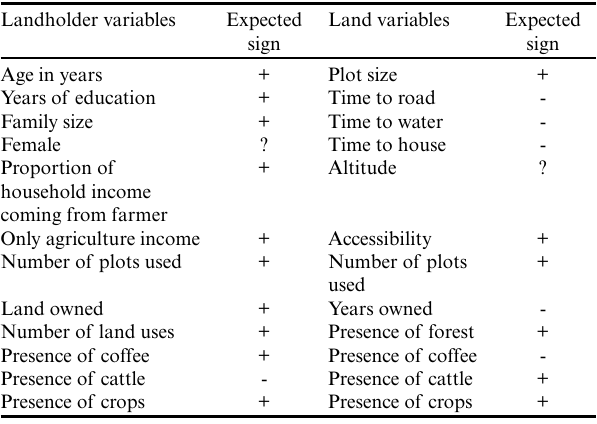
Table 1 . Independent variables that were tested for association with two levels of opportunity costs, per landholder and per land plot, and their expected